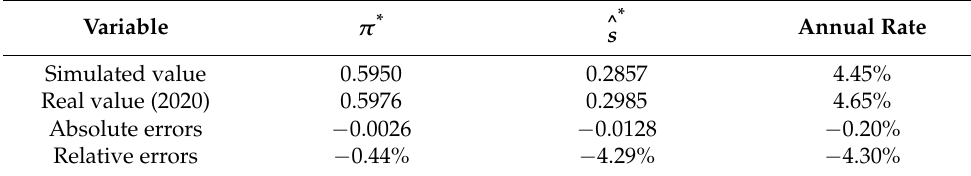
Table 2. Numerical